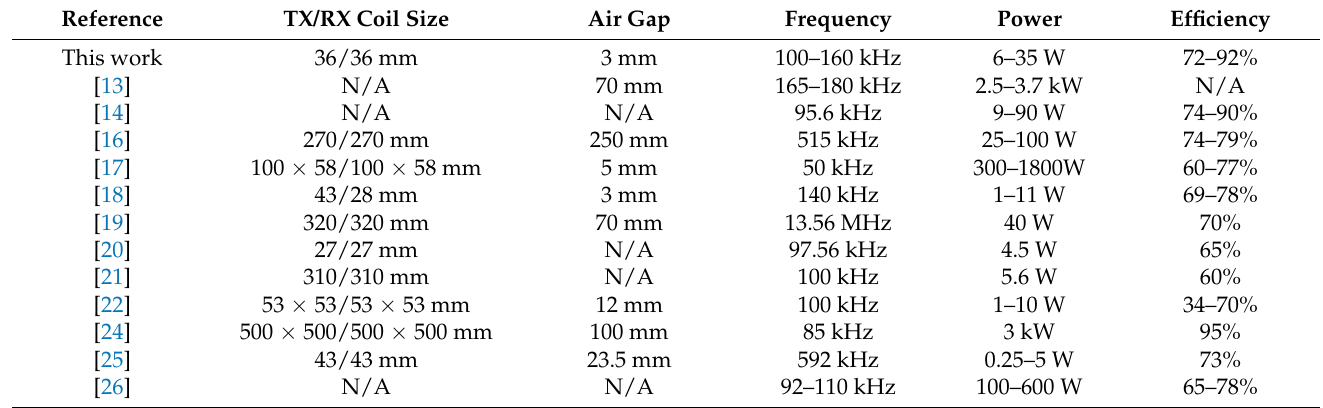
Table 9. IPTS specification comparison.